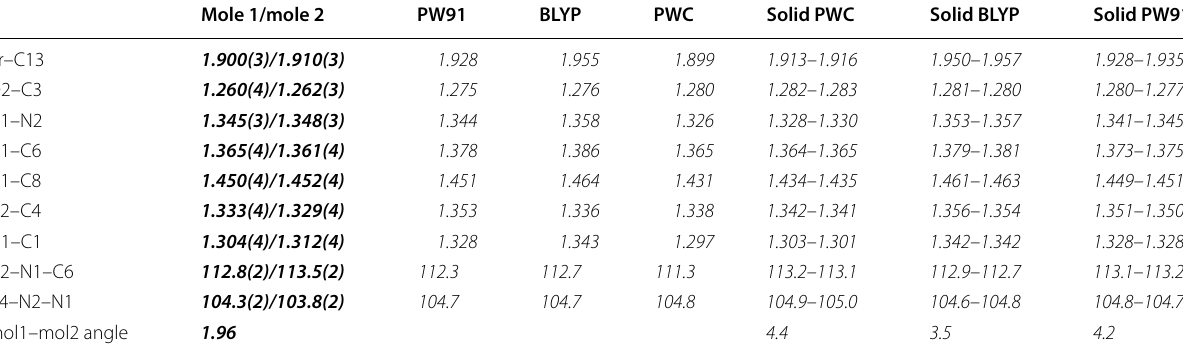
Experimental (bolditalic) values in the crystal are compared with values calculated (italic) in molecular or 3D models